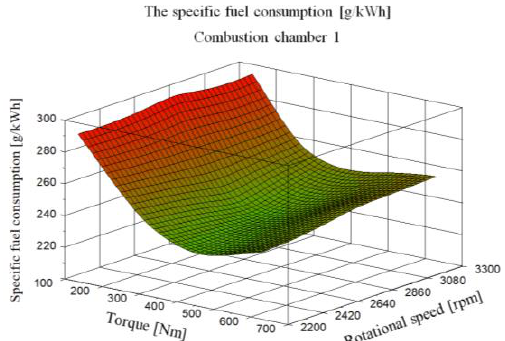
Figure 20. The specific fuel consumption of the engine equipped with the combustion chamber 1.